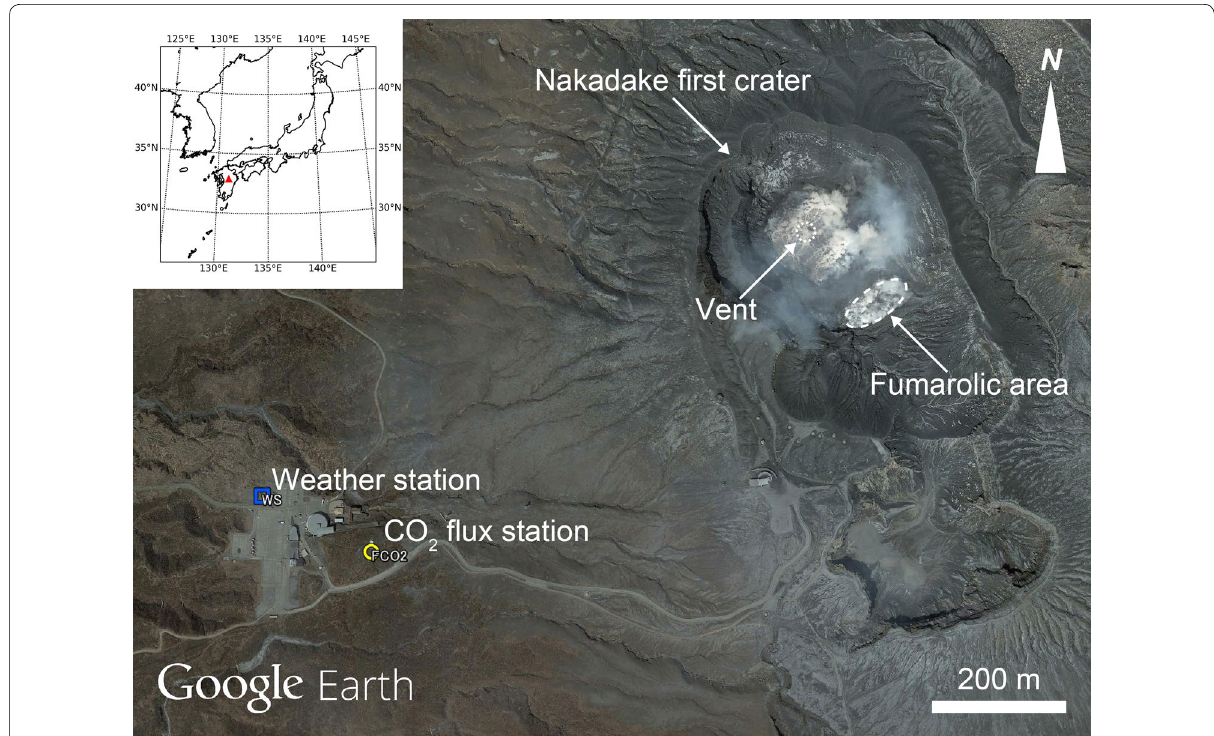
Fig. 1 Location of the soil CO 2 flux station (yellow circle) and weather station maintained by the Japan Meteorological Agency (blue square). The location of Aso volcano is depicted with a red triangle in an inset. The background satellite image (captured on 15 April 2016) is from Google Earth (https ://earth .googl